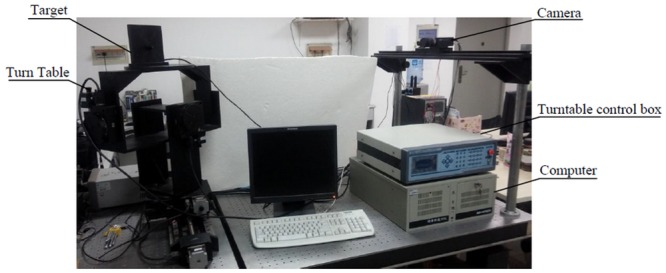
Experiment devices.